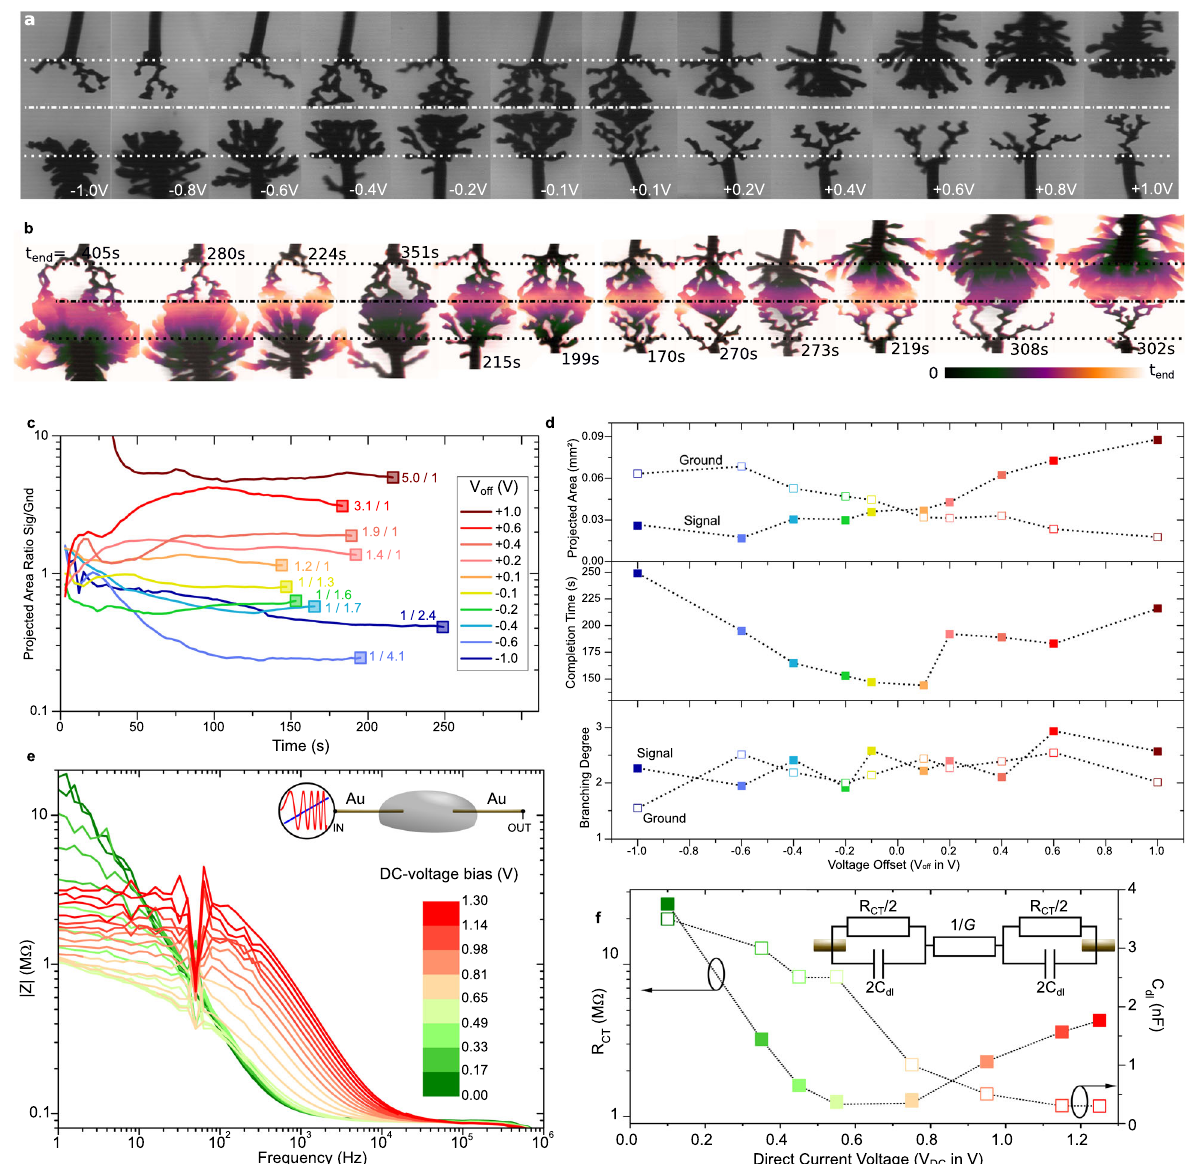
Fig. 3 Asymmetry control by the voltage offset ( V off ). a Microscope pictures of ePEDOT dendritic formation after t = 150 s of voltage polarization under different V off ( V p = 5 V, f = 80 Hz, dc = 50%). b Color-encoded temporal images of the same dendrites grown from 0 to t end (color scale as inset as linear scale with time). c Ratio between the projected area of signal ’ s dendrite and ground ’ s over time, for dendrites grown at different V off . d Projected area, completion time, and branching degree over V off for dendrites grown up until contact. e Voltage-ramped impedance spectroscopy between V DC = 0 and 1.3 V of the two-gold-wire setup immersed in the same electro-active electrolyte (10 mM BQ (aq) , 10 mM EDOT (aq) , 1 mM NaPSS (aq) ) that displays a bias- dependent high-pass fi lter property (the effect of an ePEDOT coating on either or both wires is provided as a Supplementary Material). f Extracted R CT and C fi tting of the spectrum on the idealized equivalent circuit depicted as an inset ( G = 8.5 ± 0.2 µ S). Scatters and curves ’ color dl parameters from the encodings with a voltage offset in c and d are identical. Scatters and curves ’ color encodings with DC voltage in e and f are fi eld orientation controls the growth only for low growth rates, as Con fi rming the voltage activation of the growth, it also invalidates the thin dendrites appear straighter along the fi eld orientation the linearity of the applied electric- fi eld E = ( V ’ sig − V ’ gnd )/ d ( d < L as shortest distance between two dendrites), with V ’ sig and than thicker ones. The observed change in growth orientation V ’ gnd being R CT ( V DC ) dependent, and therefore dependent on evidences voltage non-linearity in the charge-transfer yielding V off . Furthermore, we observed the growth continued further anodic processes of electropolymerization on wires. Non- after interconnecting, by the appearance of radial dendrites on the Ohmicity under quasi-steady conditions was evidenced by thickest dendrite wire for higher V off values (easily evidenced in voltage-ramped impedance spectroscopy (Fig. 3f). As the direct- Fig. 4b for time lapses at V off = − 0.4, + 0.2, and + 0.8 V recorded current voltage bias ( V DC ) is gradually increased over time in the experiment, we observed a sudden decrease in the charge-transfer until t end longer than their respective completion time). Such resistance R CT = R ox + R red when approaching V DC = Δ V min , feature indicates good conduction for these asymmetric objects increasing with V DC after reaching a minimum (Fig. 3f). after merging: As none of the transmission lines were loaded with